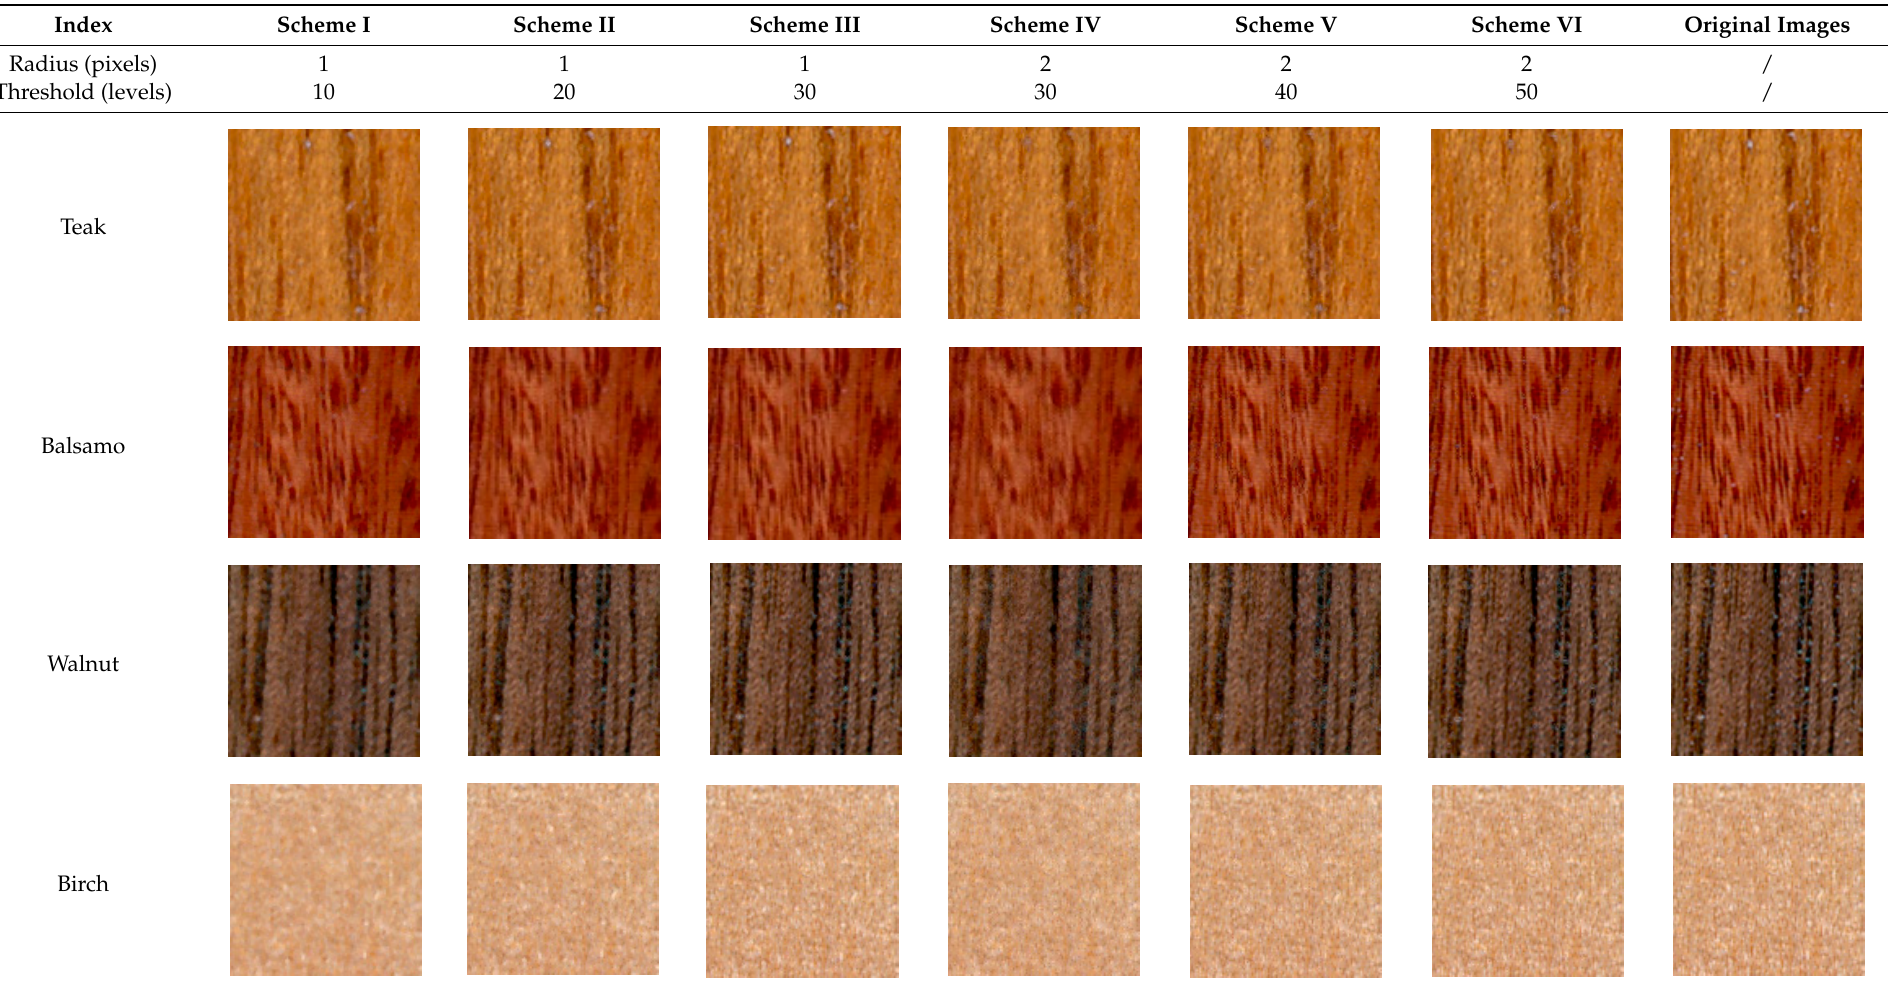
Table 2. Parameter settings and denoising effects of Dust & Scratches .